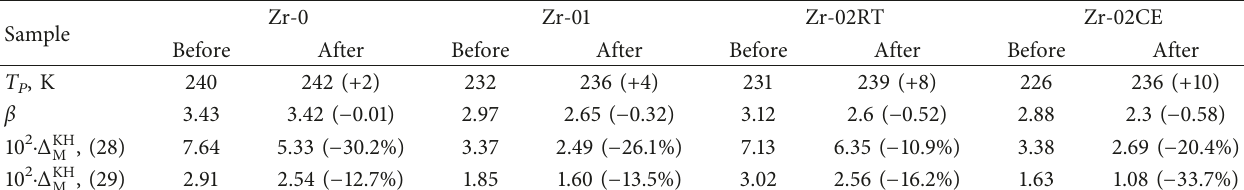
Table 3: Change of the KH peaks parameters after annealing for 1 hour at 425K. Sample